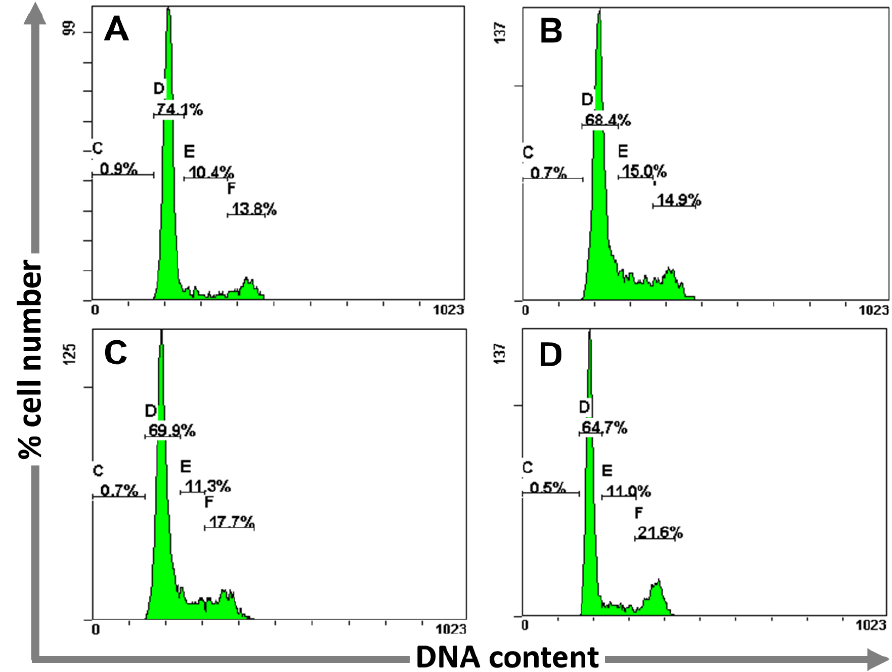
Figure 11. Flow cytometry histograms showing the effect of compound 16g on cell cycle distribution after 72 h treatment in MCF-7 cells. X -axis: DNA content of 20,000 events, y axis: % cell number. ( A ); 0 µ M; ( B ): 0.01 µ M; ( C ): 0.05 µ M; ( D ): 0.10 µ M. ( n = 3). The results revealed cell cycle arrest at the G 2 /M phase by 16g . The increase in the number of MCF7 cells in the G 2 /M phase was associated with a dose-dependent decrease in the number of cells in the G 1 phase, Figure 12.